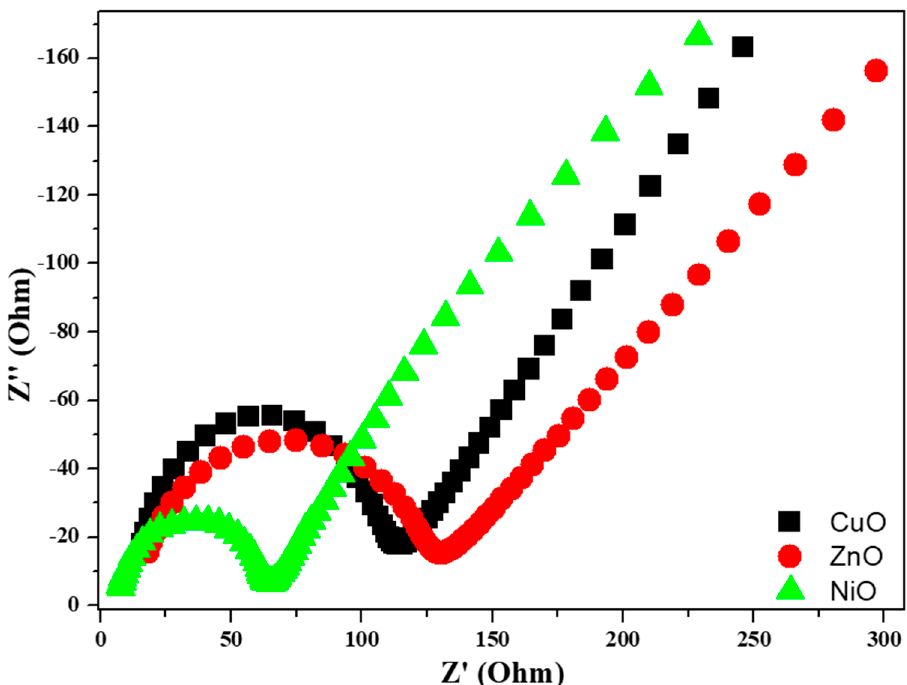
Figure 10. Plot of peak current versus square root of scan rate.